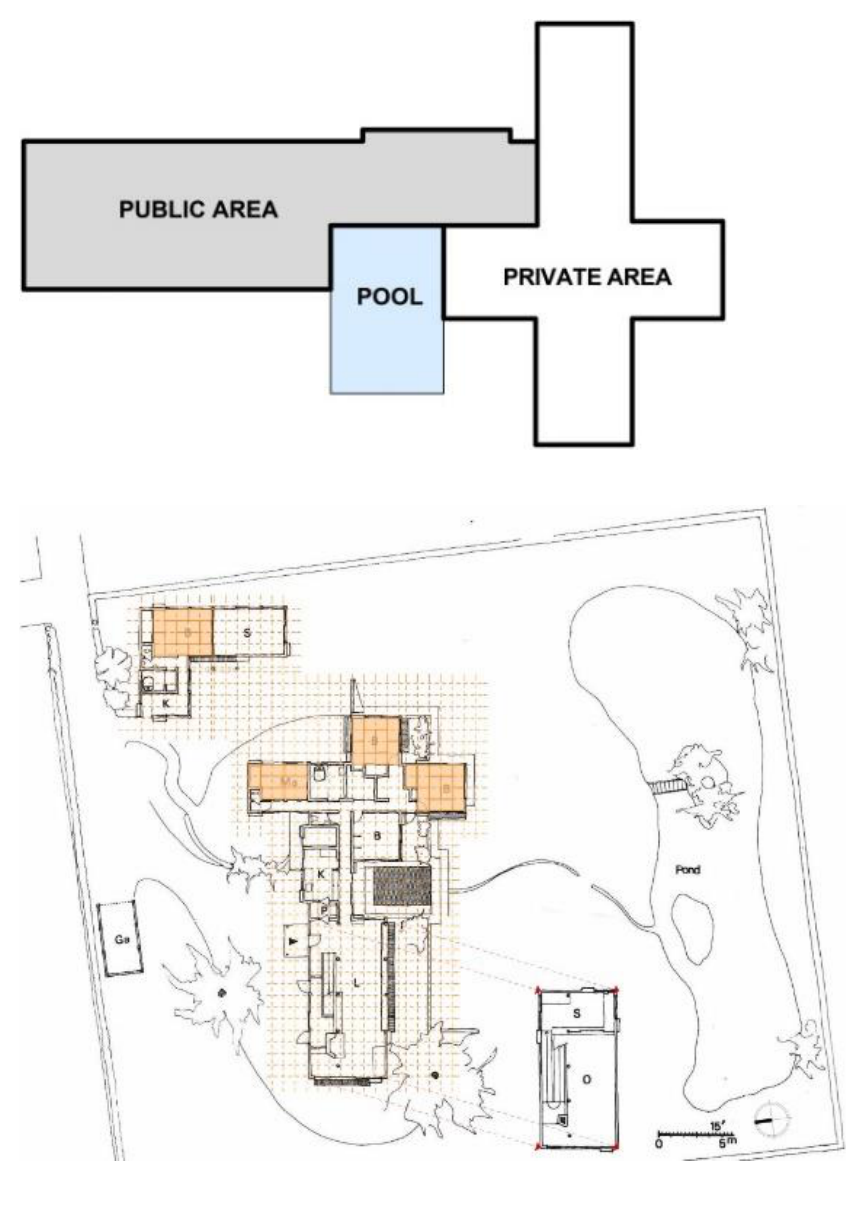
Figure 8. Karuizawa house—public and private area and the pool, plan and views. The house is composed of two main areas—the public area (living and dining room, kitchen and studio) and the private area (which included the bedrooms and the maid’s room). These two main zones are articulated by the pool, which serves as natural